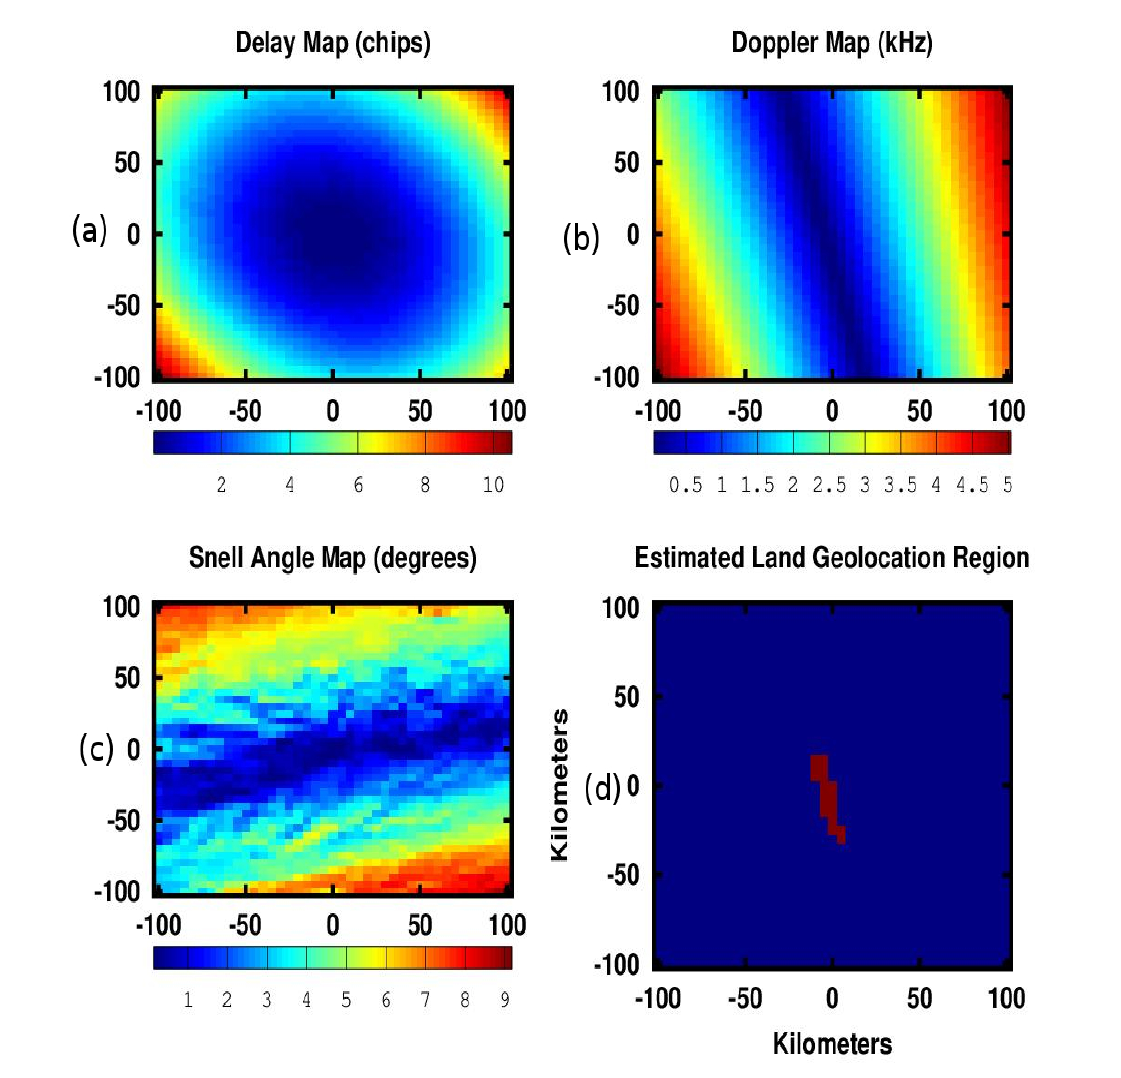
Figure 3. Contour maps of the three geolocation checks across local surface grids at second 11 of Figure 2. ( a ) Empirical delay difference ( δτ ) contour map, ( b ) Empirical Doppler difference ( δ D ) contour map, ( c ) Geometric Snell reflection angle difference ( δ Ψ ), ( d ) Logical “AND" of the delay, Doppler and Snell area checks, indicating region which satisfies the tolerance limits of all three forward reflection geolocation